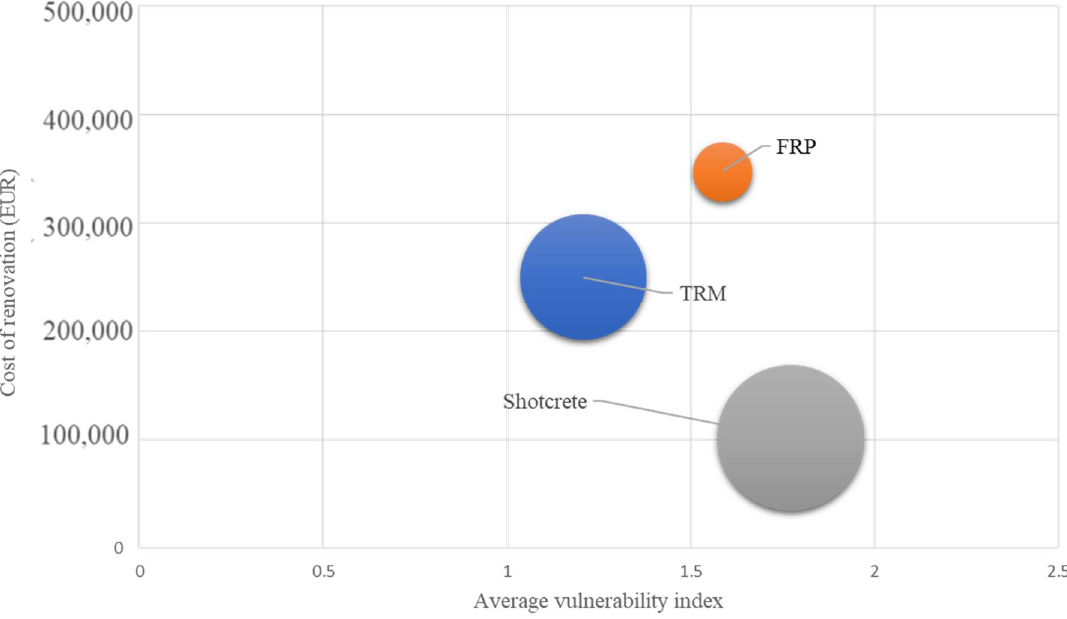
Figure 27. Comparison of methods based on renovation costs, average vulnerability index, and environmental impact.